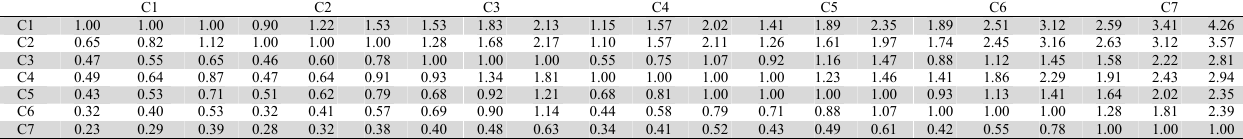
The summary of pairwise comparison of green supply chain